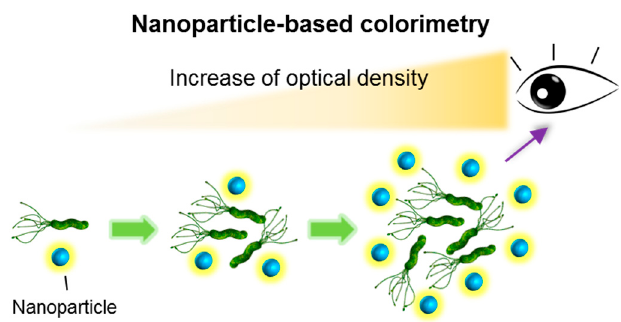
Figure 1. Schematic for the colorimetic detection of pathogenic bacteria in buffer and/or food suspensions using nanoparticles. Nanoparticles coated with antibody molecules capture target pathogens. As the number of particles increase, the nanoparticles’s optical signal can be enhanced in proportion to the nanoparticles. Increased colorimetric signals can be detected using the operator’s naked eye.